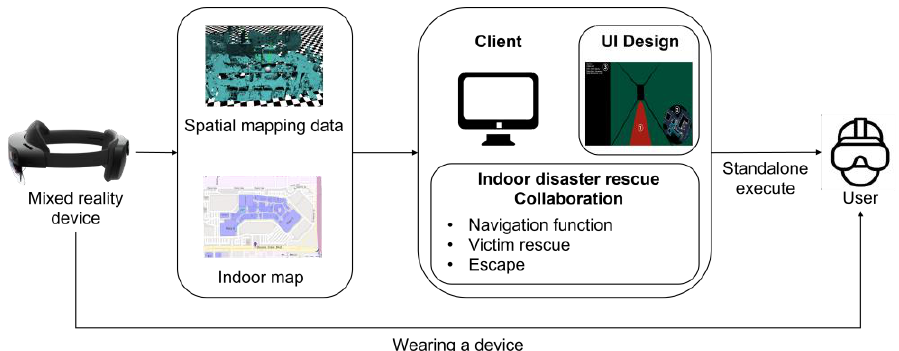
Figure 2. Overview of the mixed reality (MR) system simulating indoor disaster rescue.